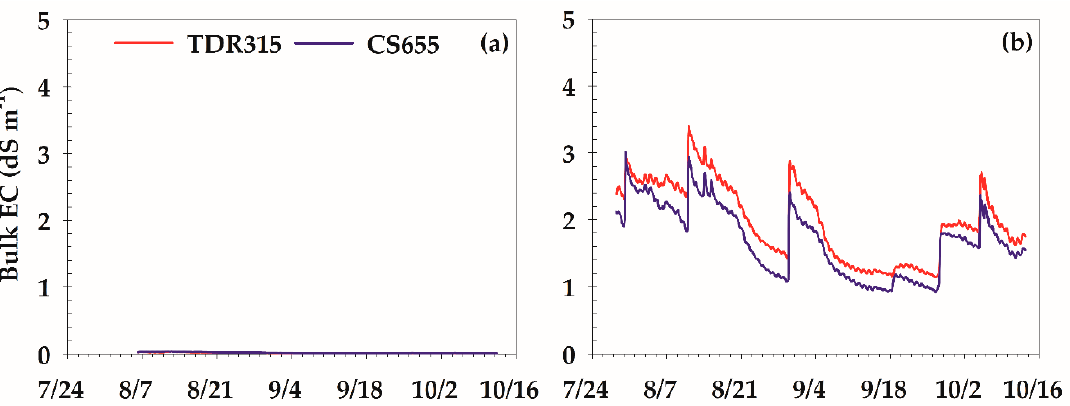
Figure 4. Time series of sensor-estimated Bulk electricity conductivity (EC) at ( a ) LSLC and ( b ) HSHC sites.